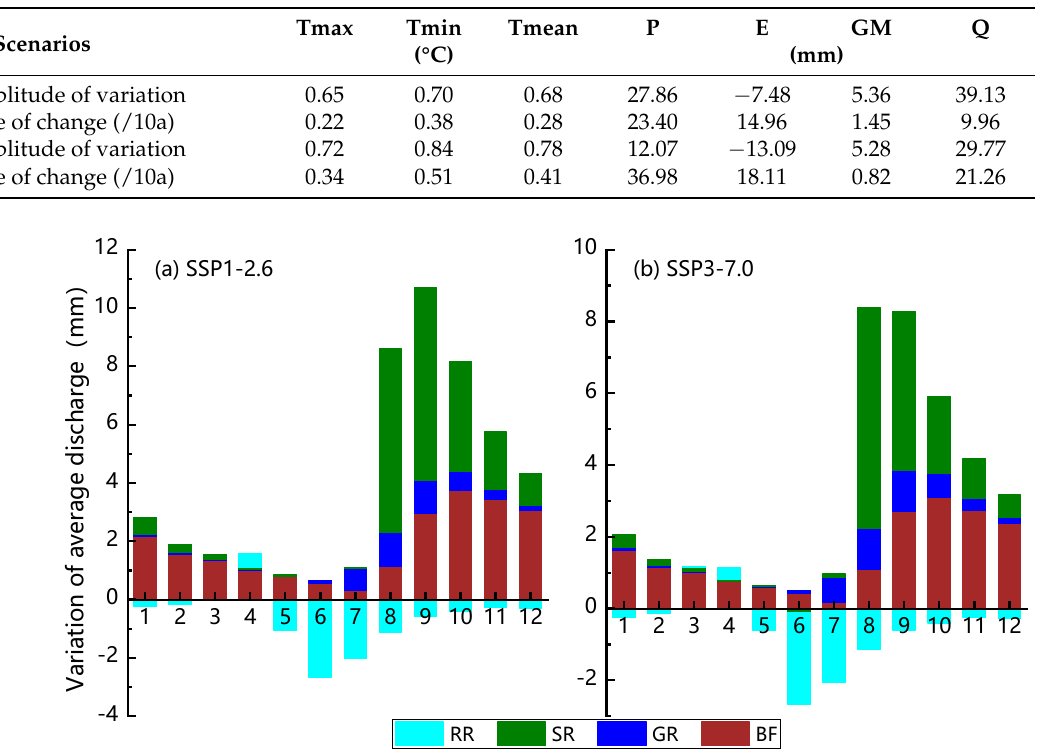
Table 5. Variation of temperature, precipitation, evaporation, glacier melt and runoff under different climate scenarios.